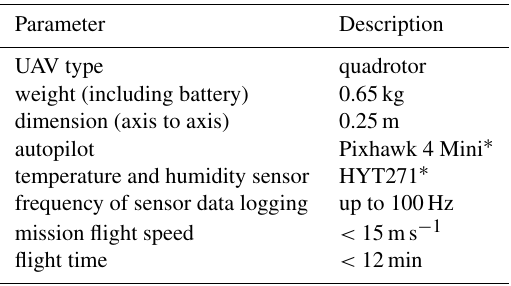
Figure 1. Picture of quadrotor Holybro QAV250 in front of the mast at Falkenberg. Photo by Bernd Lammel. Table 1. System description of quadrotor Holybro